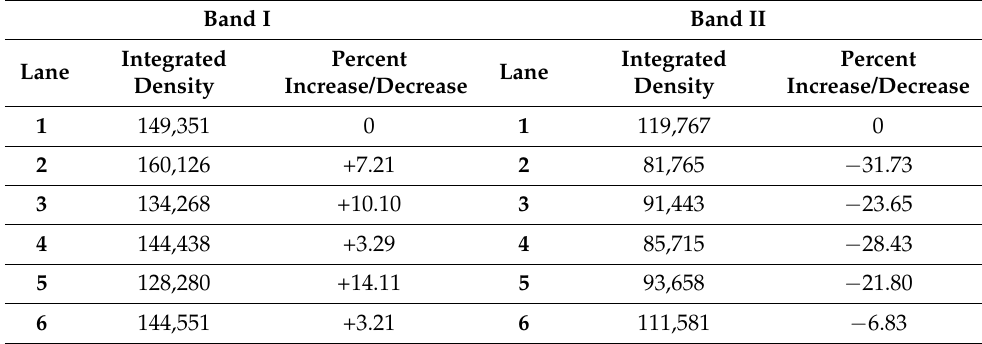
Figure 12. Agarose gel electrophoresis of plasmid DNA. ( A ) The effects of NSAE on DNA damage induced by glycation of D-ribose with lysine in the presence of Fe+2. Samples were incubated as follows: Lane 1: DNA; Lane 2: DNA+Lysine+D-ribose+FeCl 3 (GS); Lane 3; DNA+AG; Lane 4: DNA+GS+AG; Lane 5: DNA+NSAE; Lane 6: DNA+GS+NSAE. The X-axis in ( B ) and ( C ) represents the density, and Y-axis represents the gray value. Table 3. Percent increase or decrease in the integrated density of electrophoretic bands.